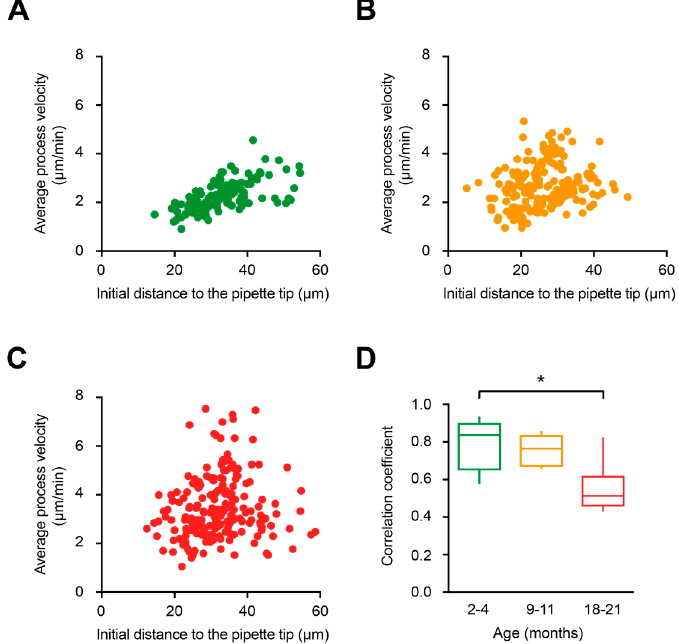
Figure 6. Relationship between the initial distance to the ATP-containing pipette and the process extension velocity. ( A – C ) Scatter plots illustrating the relationship between the initial distance of microglial process to the tip of the ATP-containing pipette (X-axis) and the mean process velocity (Y-axis) in 2–4- ( A ), 9–11- ( B ), and 18–21- ( C ) month-old mice. ( D ) Box-and-whisker plot illustrating Spearman’s correlation coefficients (per mouse) between the initial distance of microglial processes to the tip of the ATP-containing pipette and the mean process velocity in 2–4- (green), 9–11- (orange) and 18–21- (red) month-old mice. Spearman’s correlation coefficient in 18–21-month-old mice was significantly lower compared to that in 2–4-month-old mice ( p = 0.03 for 2–4- vs. 18–21-month-old mice, p = 0.99 for 2–4- vs. 9–11-month-old mice and p = 0.13 for 9–11- vs. 18–21-month-old mice, Kruskal–Wallis test; n = 5, 5, 6 mice for 2–4-, 9–11-, and 18–21-month-old mice, respectively). * p < 0.05 in ( D ).